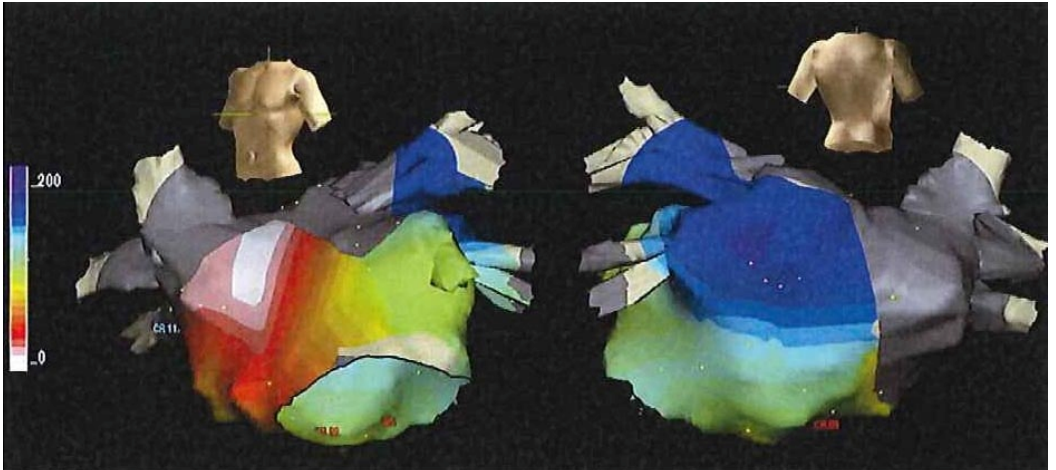
Figure 6. Virtual anatomic rendering of the LA in a patient with typical biphasic (±) P-wave in leads II, III, and aVF suggestive of A-IAB (Bachmann’s region block). Note that early left atrial activation ( white ) occurs at the high septal wall, as expected for Bachmann region conduction. Activation does not progress through the left atrial roof because of the presence of a large zone of low voltage ( gray ) that diverts activation toward the low septal ( orange - yellow ) then the low posterior ( green ) and finally the high posterior ( violet ) left atrial wall. (Taken from reference 19).